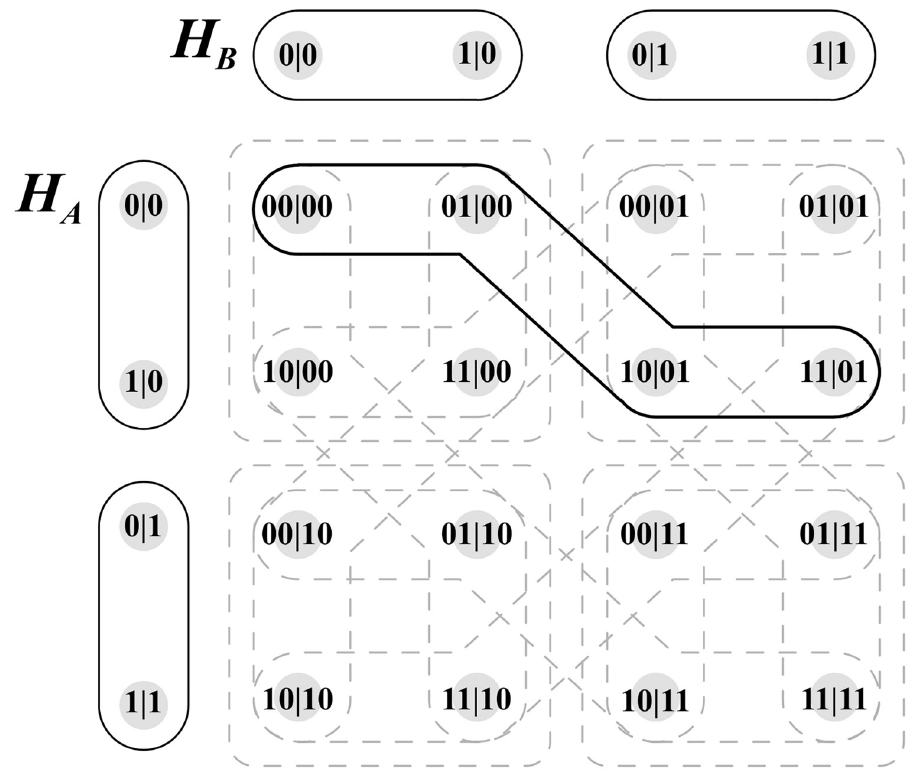
Fig 6. Visualisation Of hyperedges associated with vertex